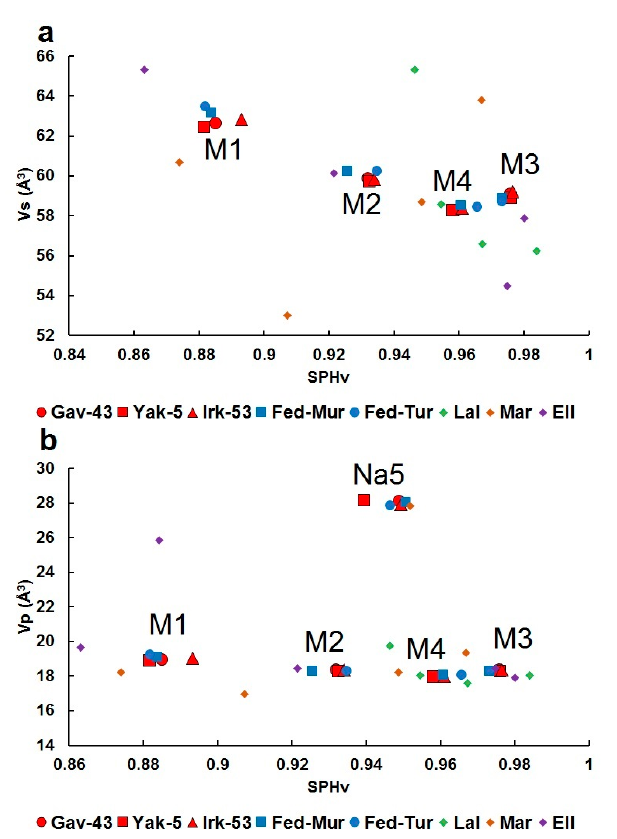
Figure 9. Relations between SPHv (volume sphericity) and vs. (volume of the sphere) ( a ) and Vp (volume of the coordination polyhedron) ( b ) for M1-M4 (a,b) octahedra and Na5 polyhedron (b) in the fedorite under study (sample Gav-43, Yak-5, Irk-53, Murun complex), fedorite from Murun (Fed-Mur) and Turiy complexes (Fed-Tur) [7], lalondeite (Lal) [39], martinite (Mar) [40] and ellingsenite (Ell) [41]. Data were taken from Table S12 of Supplementary Materials.